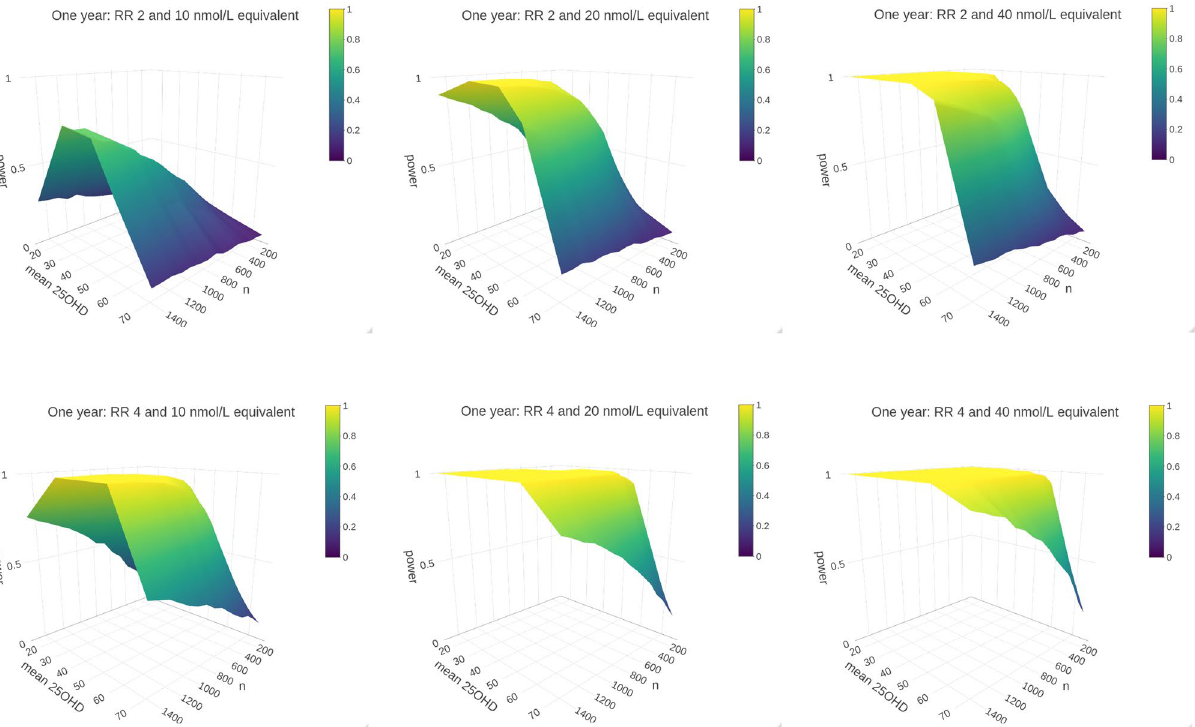
Figure 4. Power surfaces are shown for intervention that achieves a 25OHD increase of 10 nmol/L (left), 20 nmol/L (centre),and 40 nmol/L (right) versus placebo, against the sample size n and population baseline vitamin D status µ . The top row shows surfaces when relative risk of 2 is assumed between fully insufficient and fully sufficient i.e. u = 2 , and the bottom row shows the same for u = 4 . Here n gives the number of participants in each trial